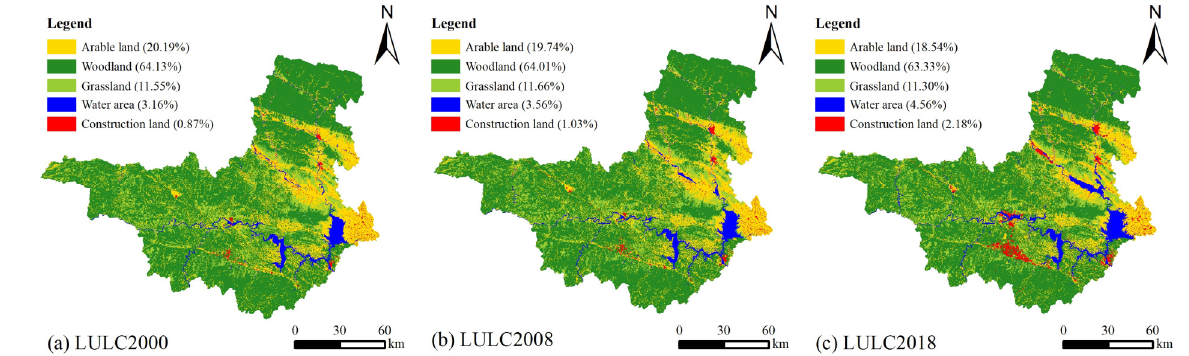
Figure 3. Land use type and proportion in the Danjiangkou reservoir area.